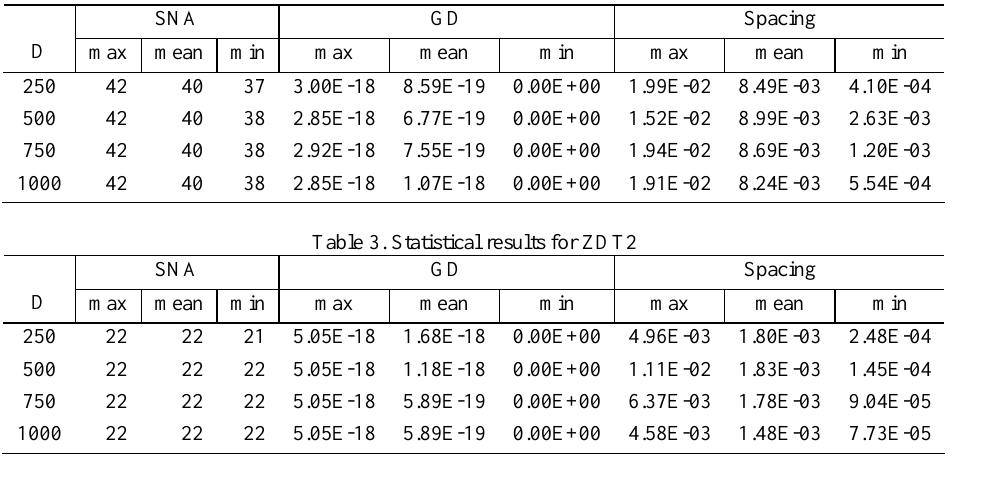
Table 4. Statistical results for ZDT4